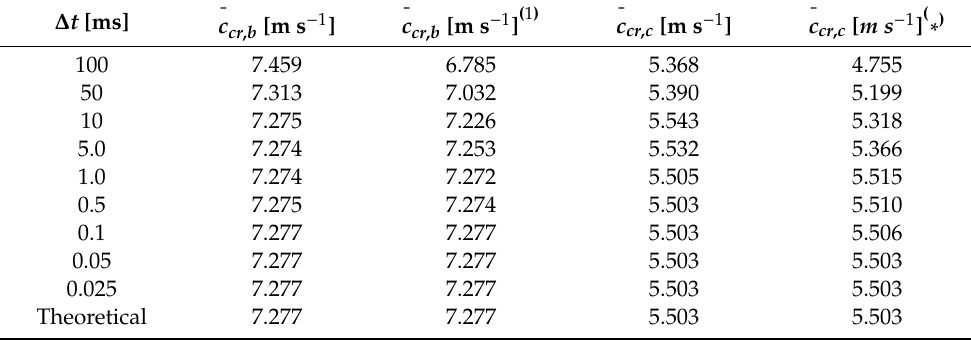
Table 5. Critical damping obtained for St. Mary’s tenor bell and clapper as function of ∆ t